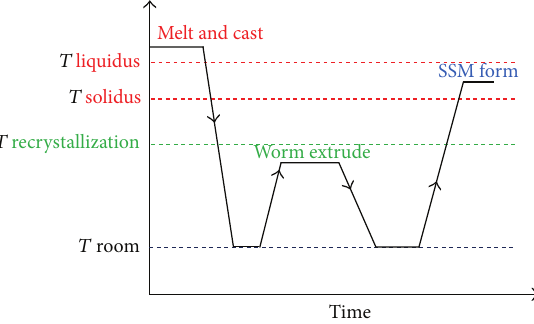
Figure 30: Process stages of the RAP method